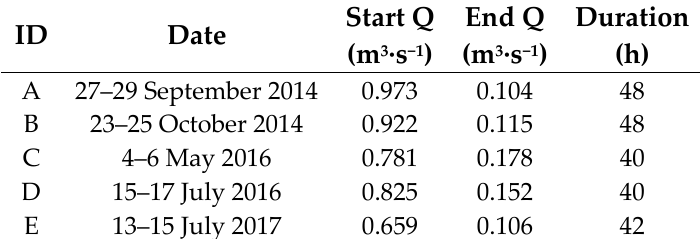
Table 1. Overview of events selected for